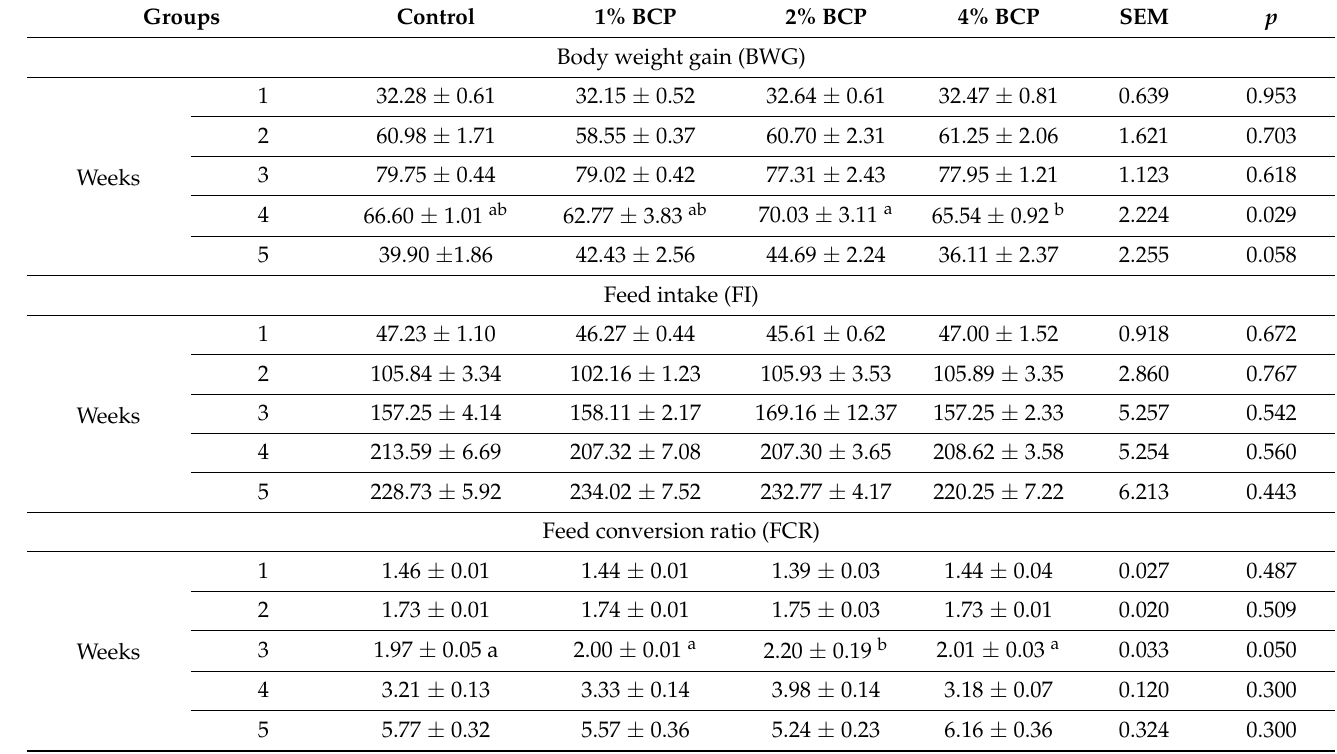
Table 1. The effect of BCP supplementation at different levels on the weekly body weight gain (g), feed intake (g), and feed conversion